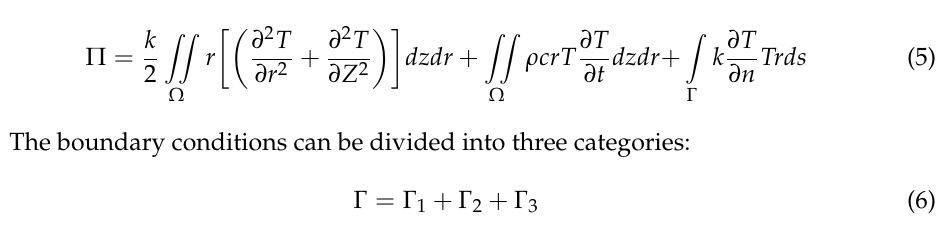
Figure 3. The heat flux density, boundary conditions and the finite element grid of the friction disc. Multiplying both sides of Equation (3) by r . The standard form of this function can be written as